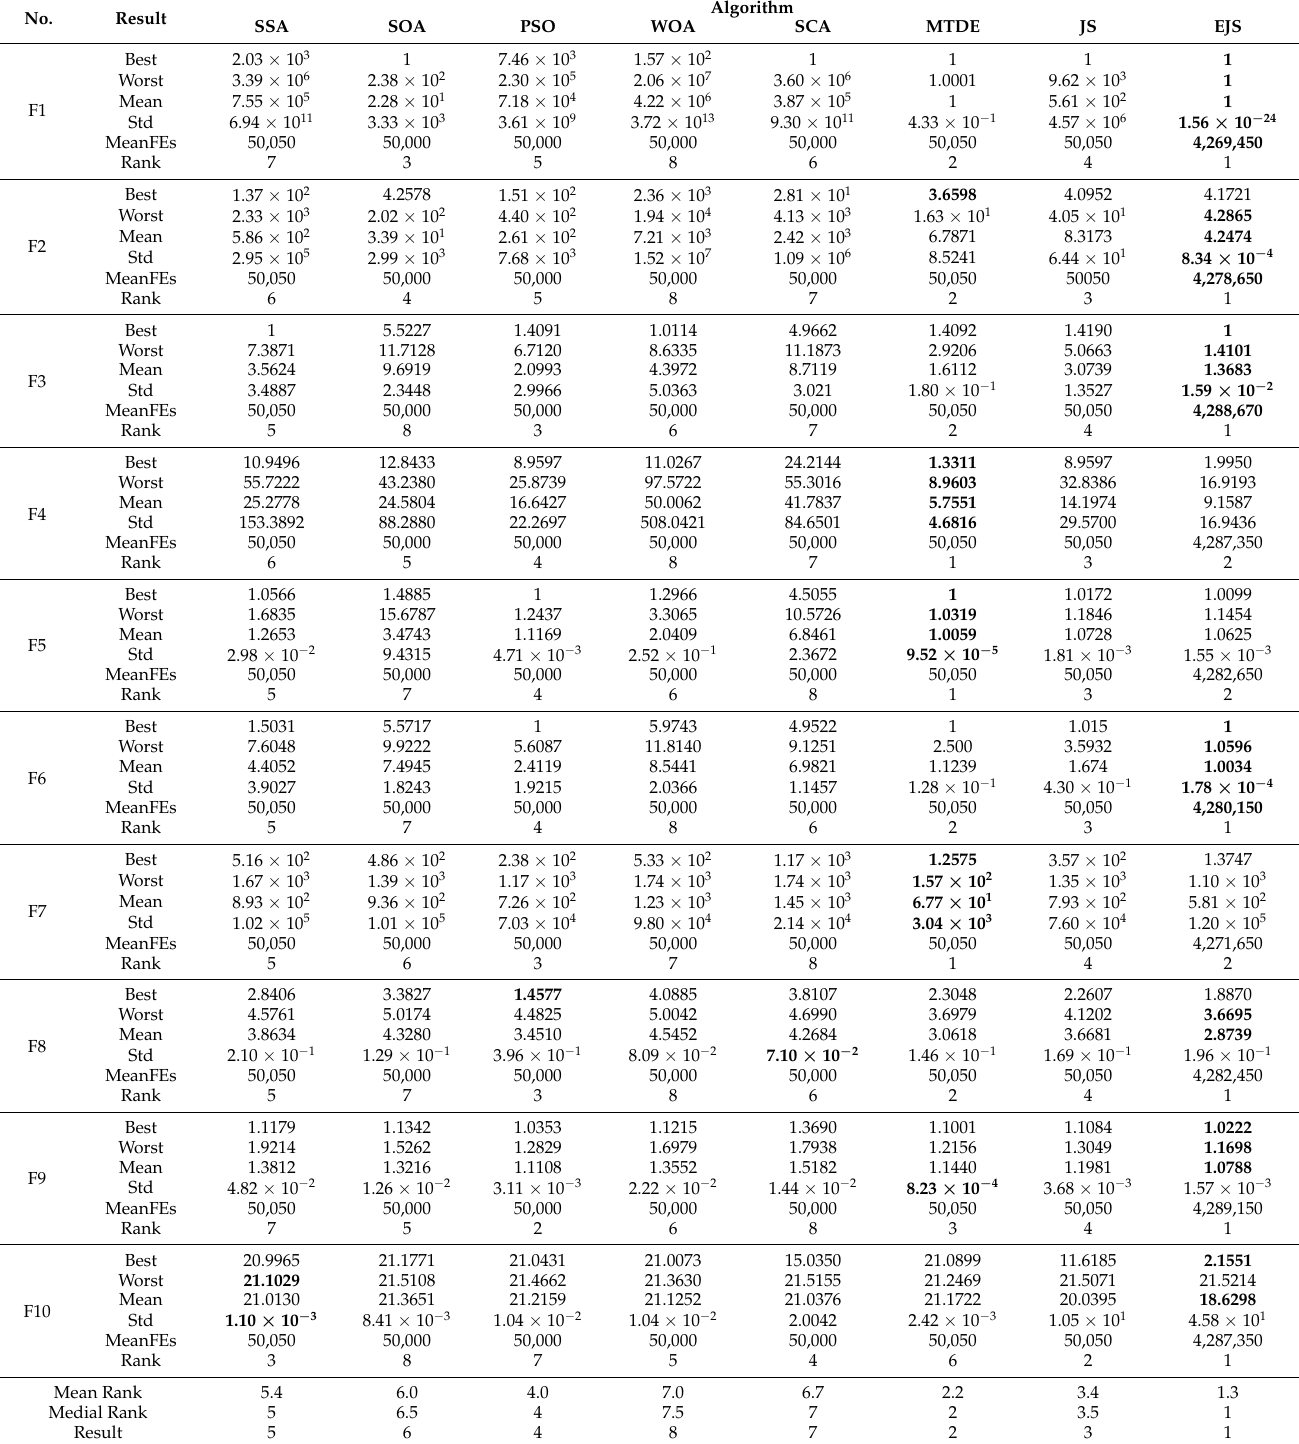
Table 4. Results of the EJS algorithm and other optimization algorithms on the CEC2019 test